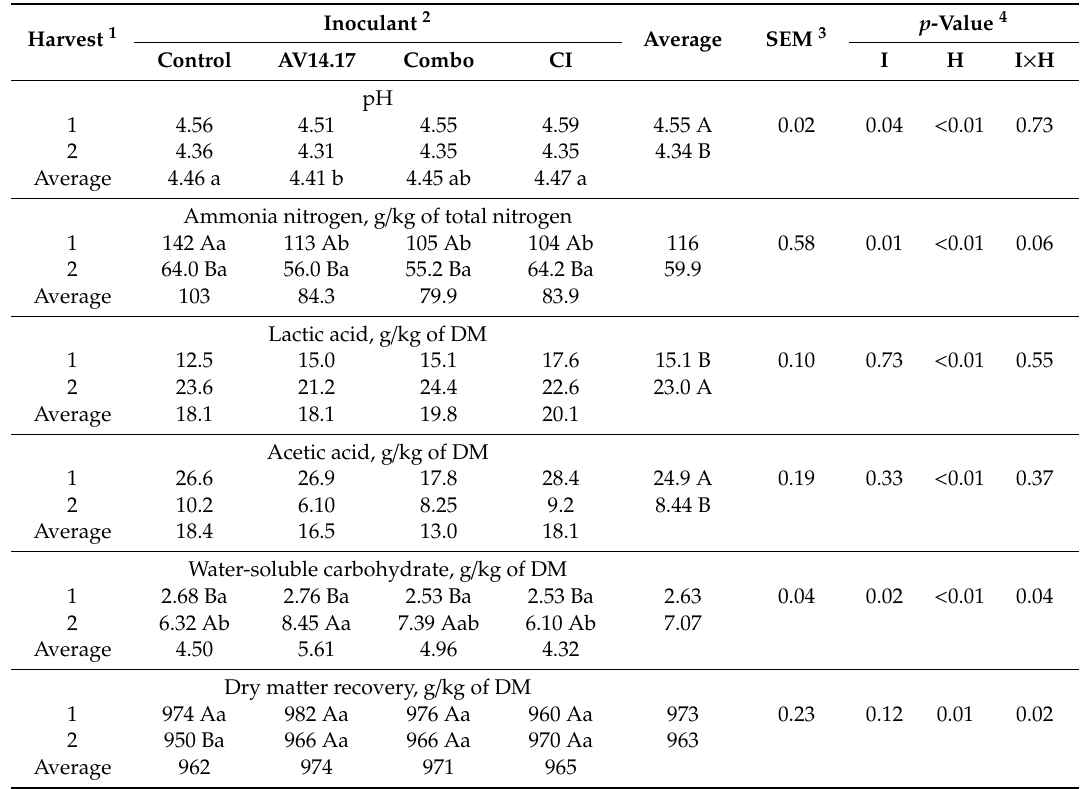
Table 4. Fermentation profile of alfalfa silage treated with microbial inoculants at two harvests. Harvest 1